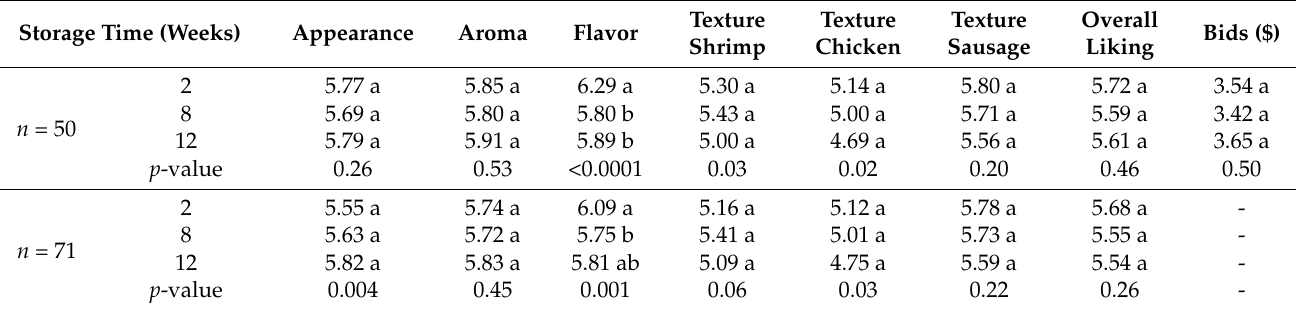
Different letters within a column (a, b) indicate the mean value of the tested parameter was different across storage times at p < 0.05 as determined using Tukey’s HSD. Mean values are collapsed over participants and processing method. Results range between 1 and 7 due to the use of a 7-point hedonic